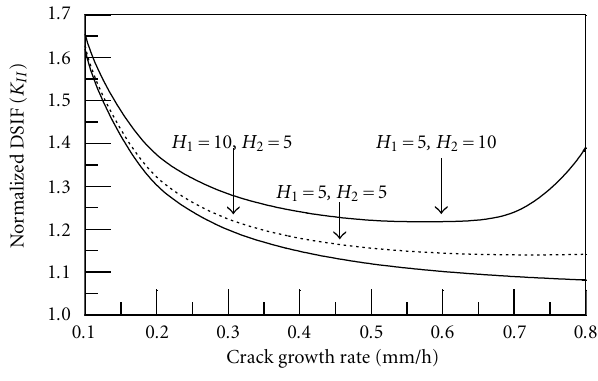
Figure 4.4. Variation of the normalized K II with the crack growth rate for di ff erent plate